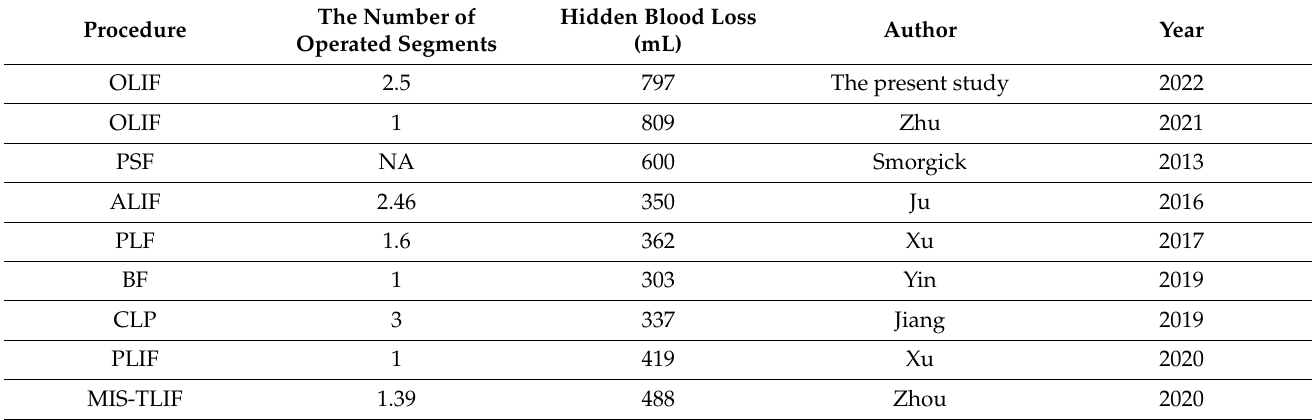
Table 3. Comparison of OLIF with other procedures in terms of